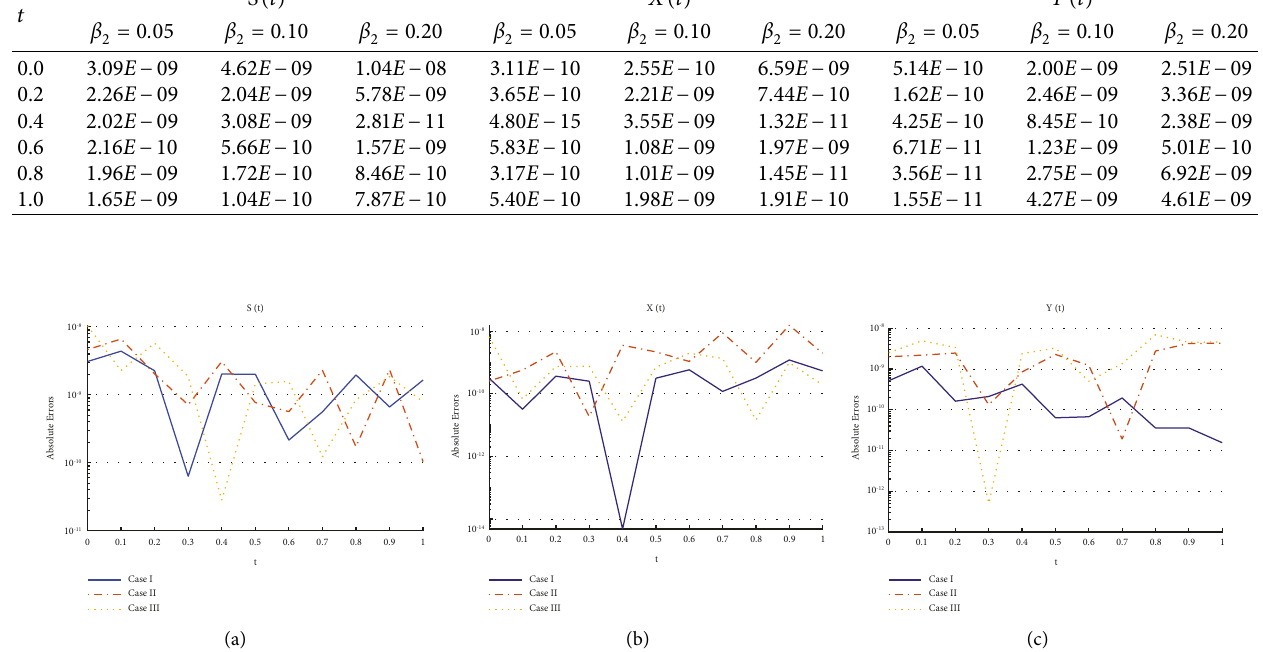
on population densities of 2